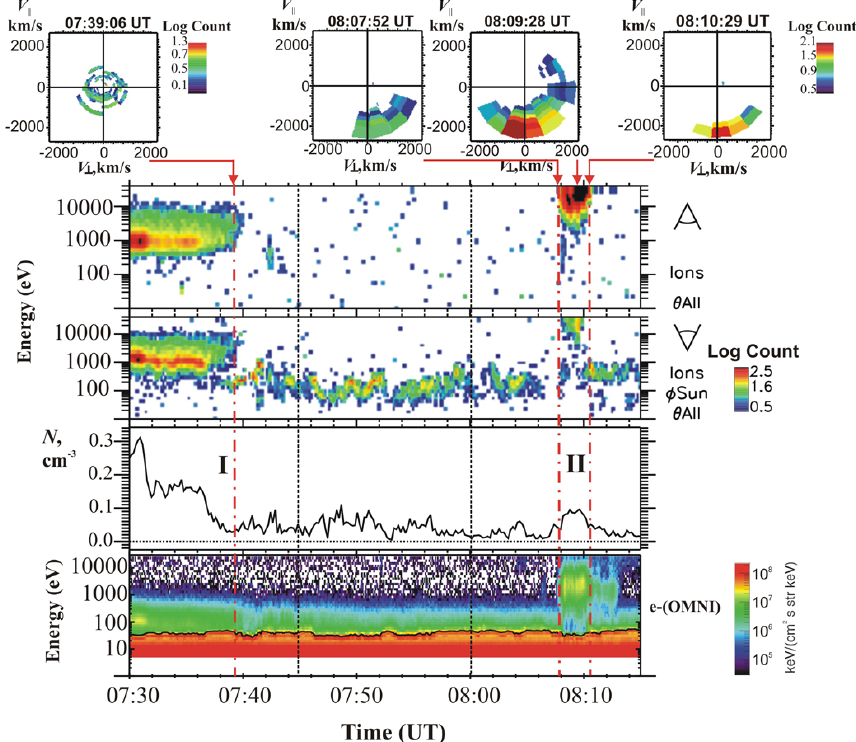
Fig. 2. PS-lobe interface crossing and PSBL encounter observed on 22 September 2001 by Cluster s/c. Ion data presented in the figure where measured by the HIA instrument onboard Cluster-1. Electron data were detected by the PEACE experiment also onboard Cluster-1. In the upper part of the Fig. 2d cuts of the ion velocity distribution functions plotted in the (V ⊥ ,V || ) plane are shown. Below, from top to bottom: E - T spectrograms of earthward and tailward moving ions and ion density N , calculated from the entire energy; bottom panel shows E - T spectrogram of omni-directional